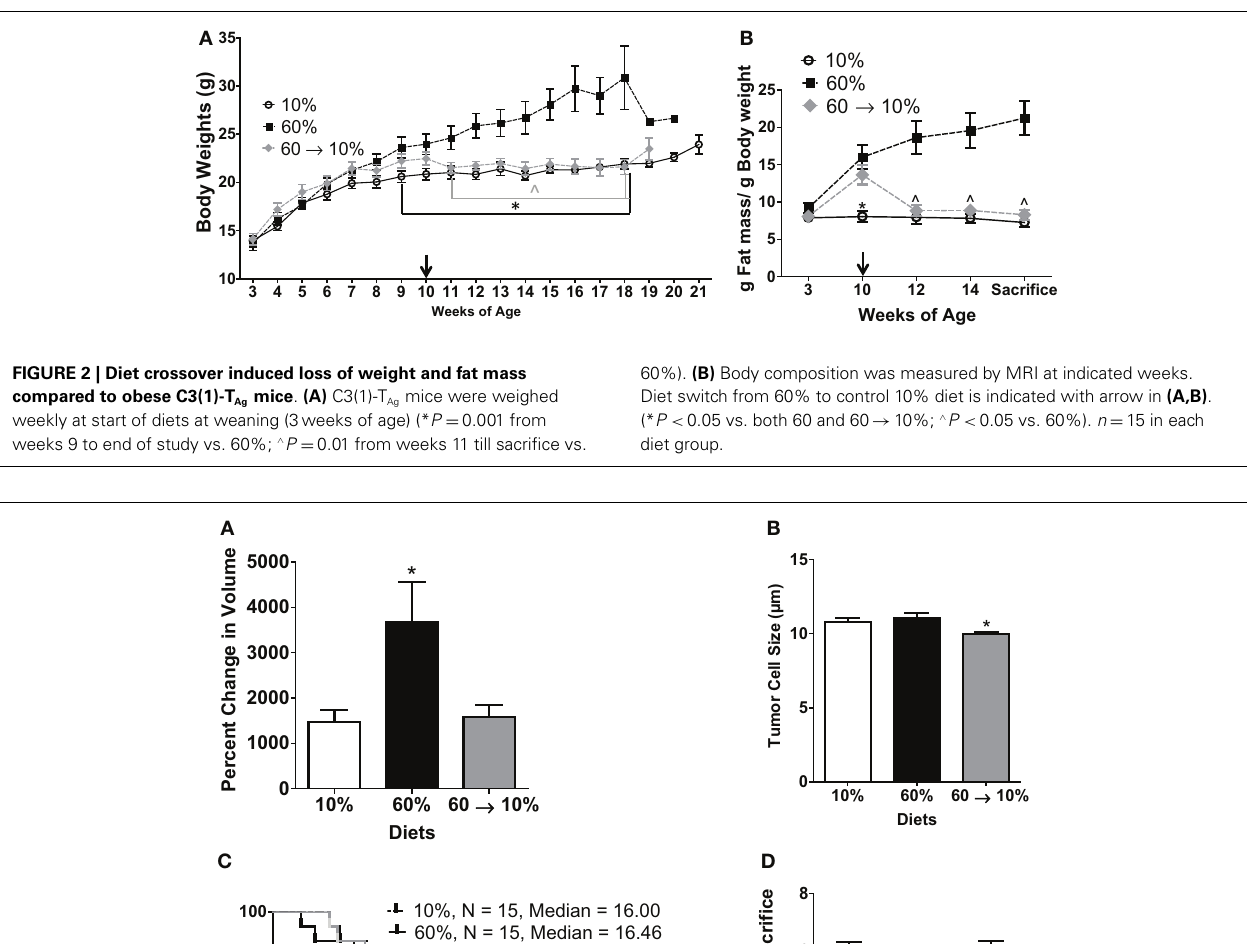
distinct fields of analyses/tumor section [* 10% ( P = 0.043) and 60% ( P = 0.019) vs. 60 → 10%]. n = 30 cells from five fields (total n = 150 cells) from five mice in each diet group. (C) Latency of first tumor identified (DF, degrees of freedom). (D) Total tumor burden was assessed at sacrifice. n = 15 in each diet